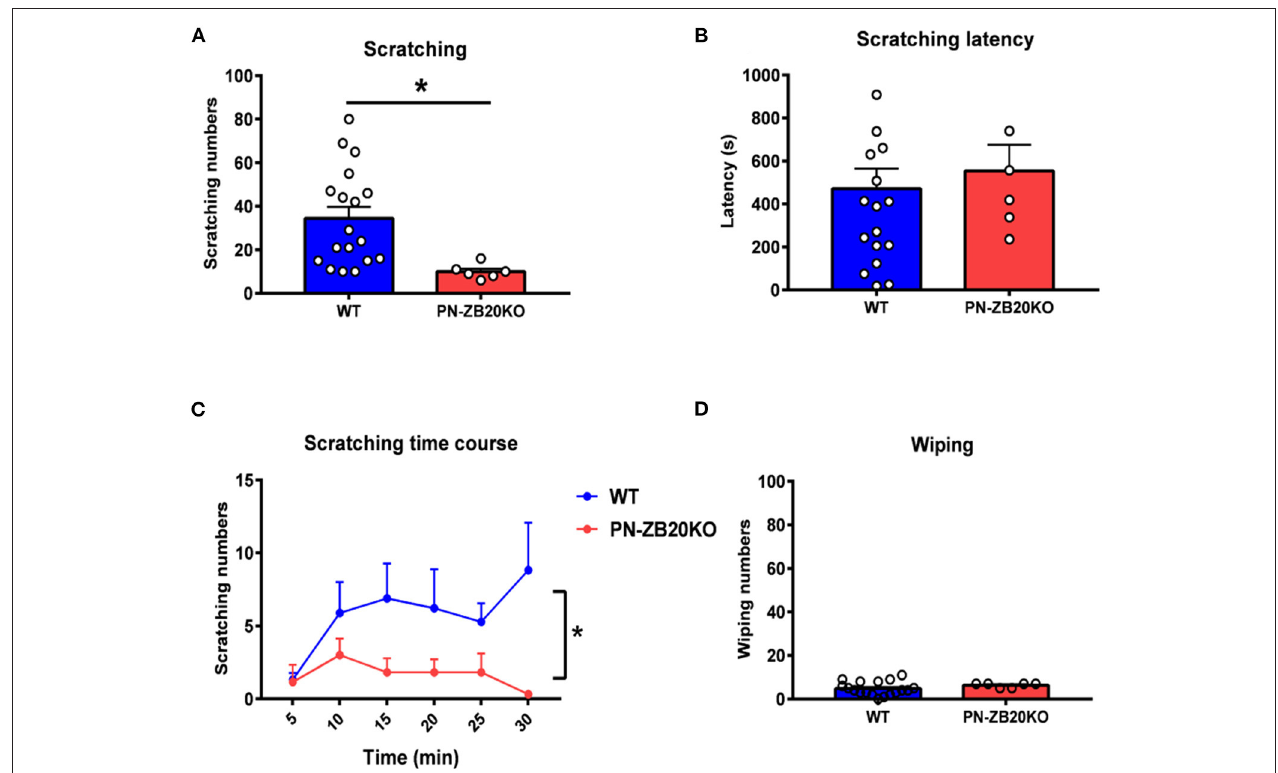
FIGURE 1 | Histamine-induced itch was dramatically attenuated in PN-ZB20KO mice. (A) The scratching behavior induced by injection of histamine (50 µ g in 10 µ L PBS) into the mouse cheek was decreased significantly in PN-ZB20KO mice compared to control mice ( t -test, * p < 0.05). (B) The latency to scratch following histamine injection did not change in PN-ZB20KO mice compared to control mice ( t -test, p > 0.05). (C) The time course of scratching behavior induced by histamine administration. Two-way ANOVA, [F (1, 22) = 6.989; p = 0.0148, * p < 0.05]. (D) The wiping induced by histamine was maintained at a low level and did not change after histamine administration ( t -test, p > 0.05). N = 6–18 for each group.